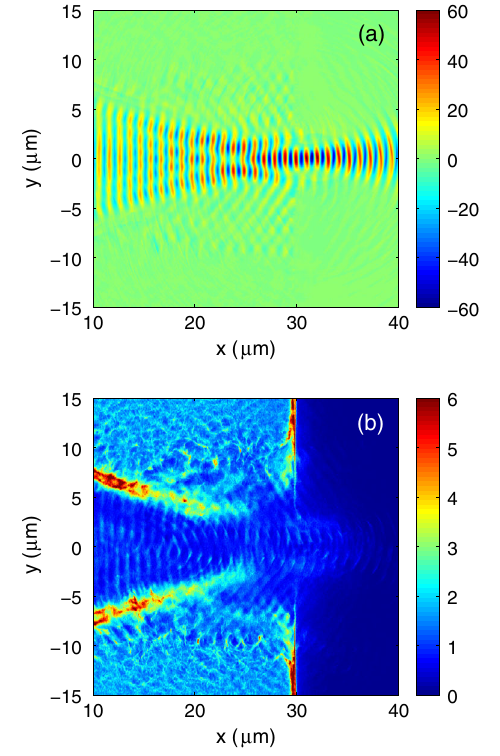
FIG. 2. (a) Wave electric field E and (b) electron density in the y carbon preplasma at 80 T , shortly after the front of the self- focused laser pulse has passed through the target. For a better view of the electron dynamics, the main carbon and hydrogen layers are not shown. Here one can clearly see the preplasma electrons propagate with the laser field as periodic microbunched ( ∼ 1 μ m thick) sheets, and they also contribute to the target-back hot electron cloud.